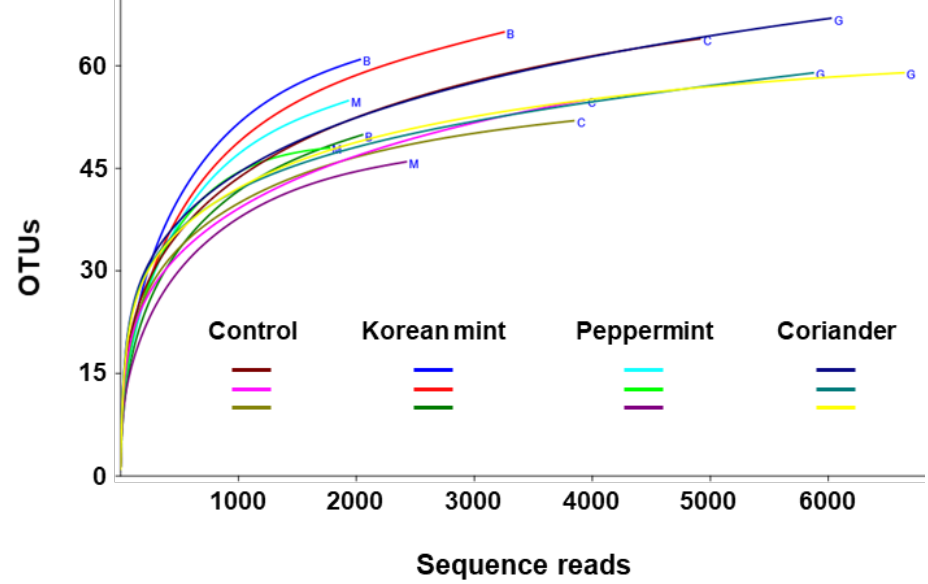
Figure 1. Rarefaction curve of 16S rRNA sequence reads obtained against assigned operational taxonomic units (OTUs) to evaluate whether further sequencing may result in the detection of additional taxa in soy paste samples prepared by adding Peppermint, Korean mint, and Coriander with respect to that in control.